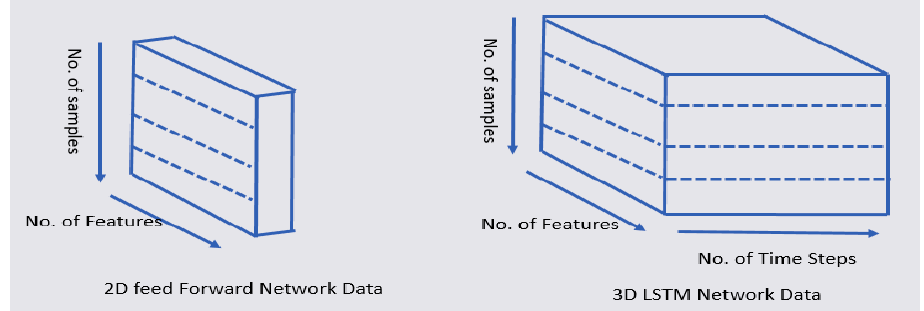
Figure 8. Transformation of 2D feed-forward data into 3D LSTM data. Table 9. Serial data for